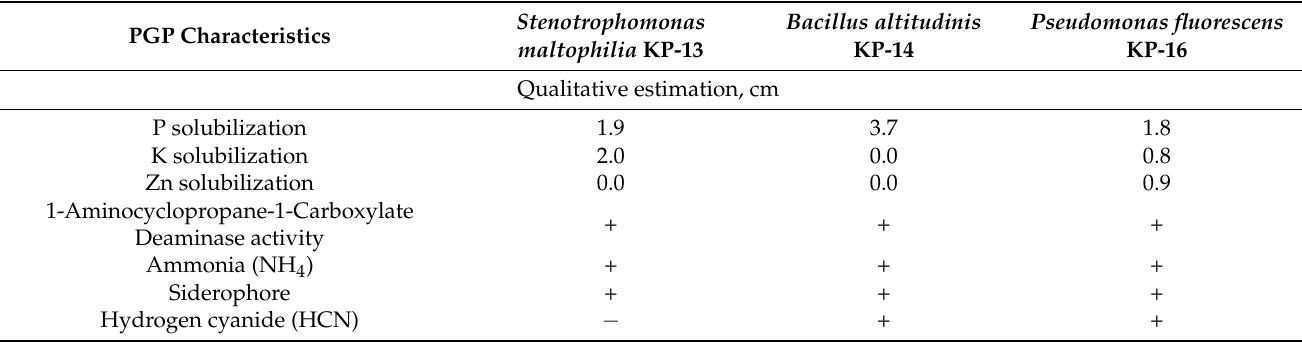
Table 1. Plant growth-promoting characteristics exhibited by the selected isolates: KP-13, KP-14, and KP-16 (modified from Pranaw et al.